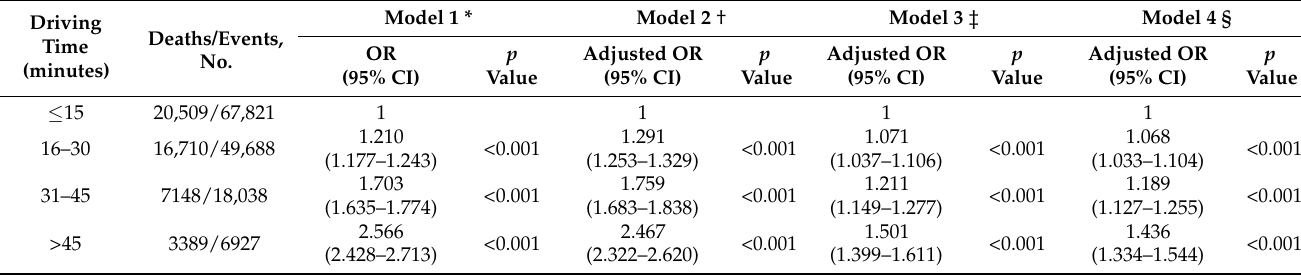
Table 2. Association between driving time to the nearest percutaneous coronary intervention-capable hospital and the risk of case fatality among patients with acute myocardial infarction.